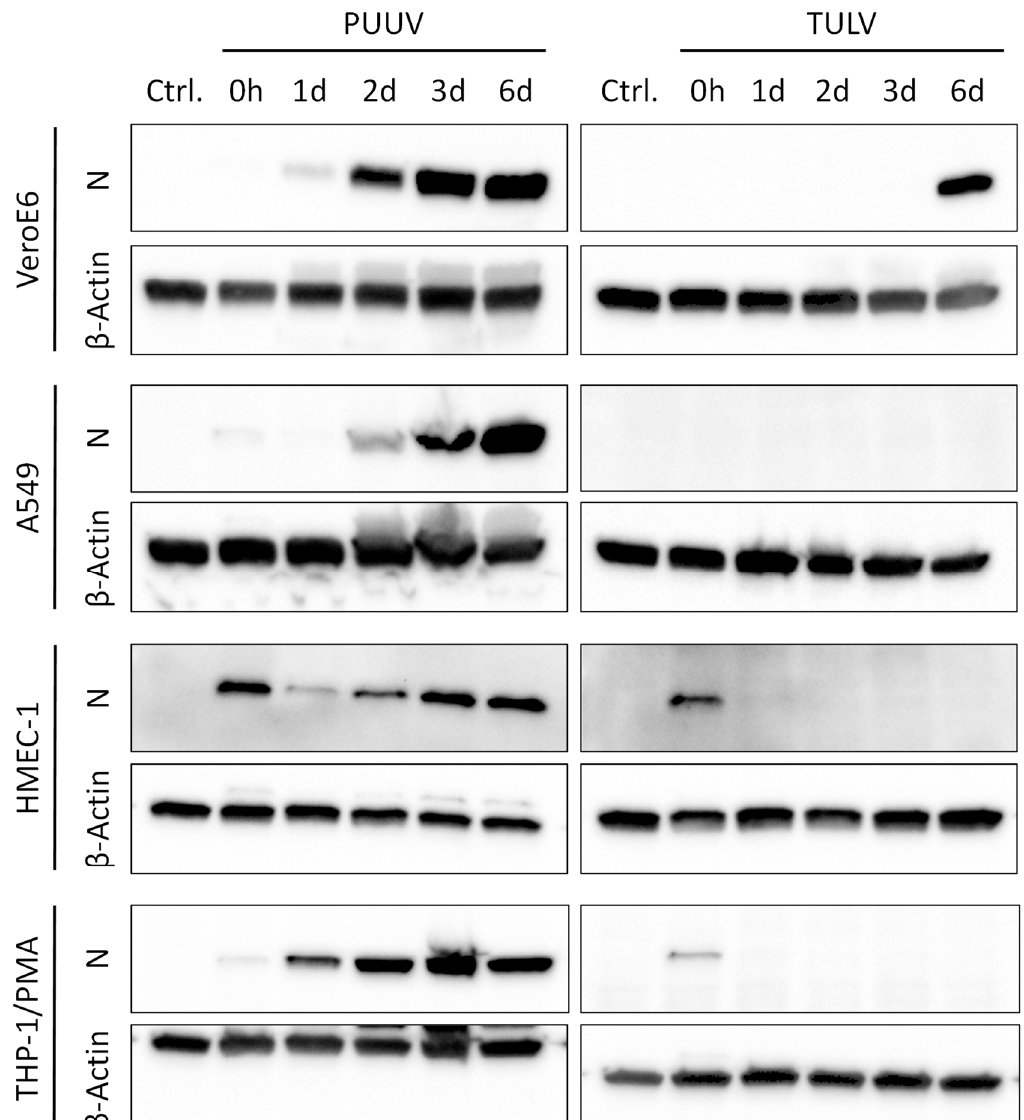
Figure 2. Viral nucleocaspid protein expression in PUUV- and TULV-infected cells. The expression of the viral nucleocapsid (N) protein was analyzed via immunoblotting in lysates of PUUV- or TULV-infected Vero E6, A549, HMEC-1, and THP-1 / PMA cells. Cells were infected with a MoI = 0.1 and N expression was detected at 0 h, 1 d, 2 d, 3 d, and 6 d post infection. Detection of β -Actin served as loading control.